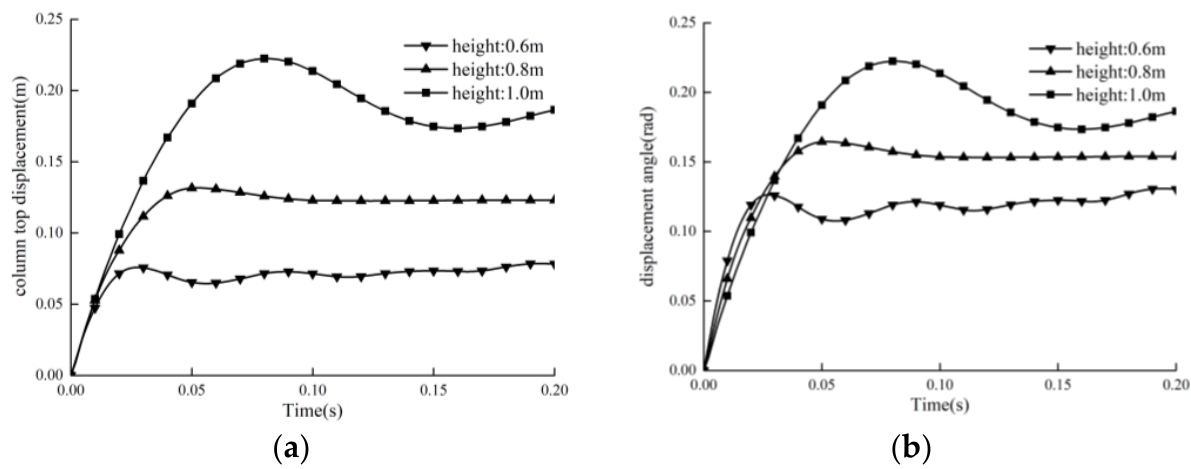
Figure 24. Comparison of RCCs with different slenderness ratios: ( a ) comparison of column top displacement; ( b ) comparison of column displacement angle.